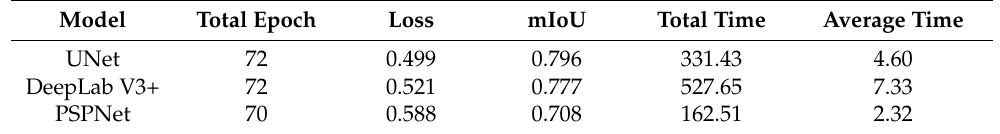
Table 3. Training parameter results of different